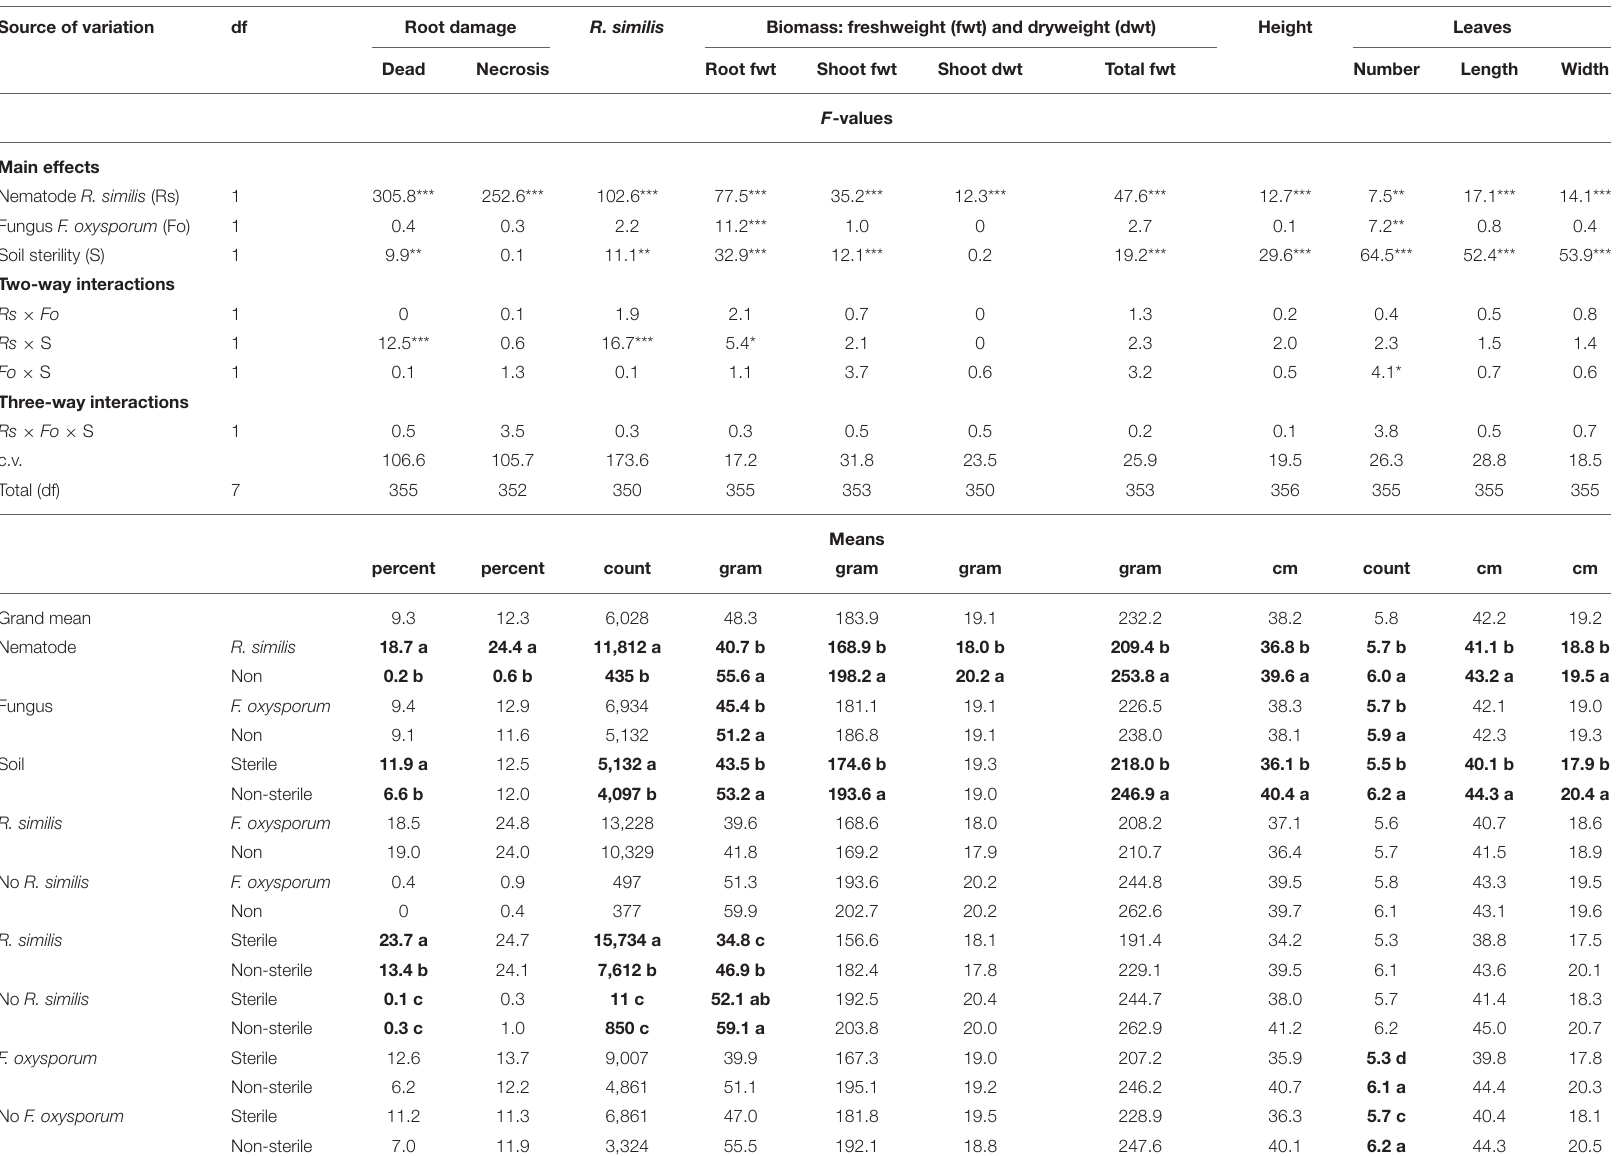
TABLE 4 | Effect of soil sterility on infection symptoms of Radopholus similis and Fusarium oxysporum V5w2 in tissue culture banana plants grown under potassium deficient conditions. Source of variation